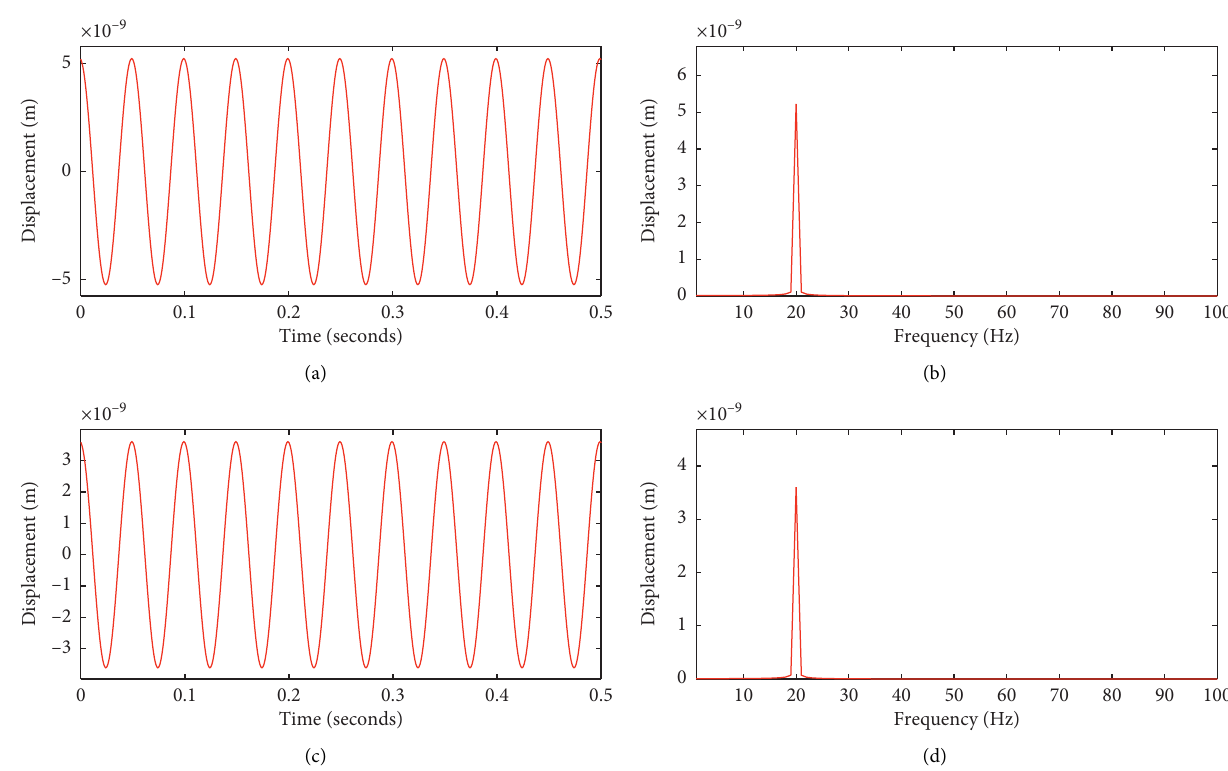
Figure 9: Response of the time and frequency domains to an imbalance in the y direction. (a) Time response of y1. (b) Frequency response of y1. (c) Time response of y2. (d) Frequency response of